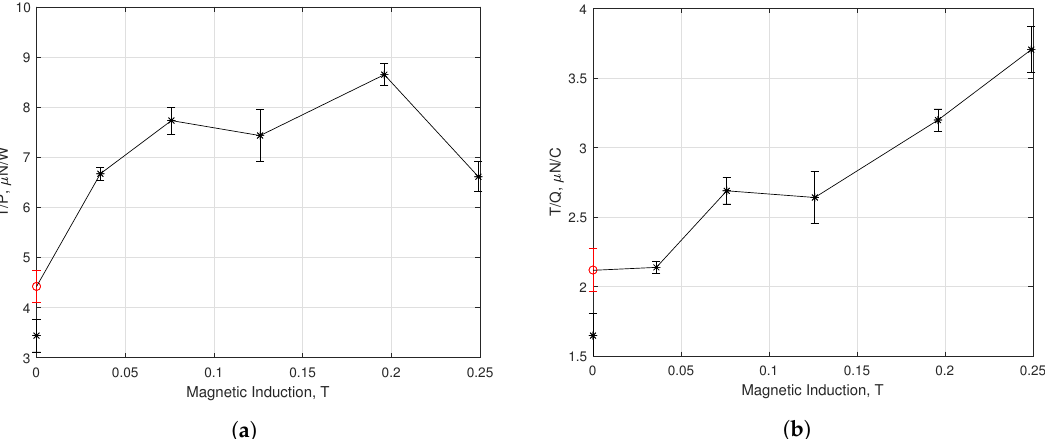
Figure 13. Thrust to arc power ( a ) and thrust to total charge ( b ) versus magnetic induction. B = 0 “no coil” results are indicated in